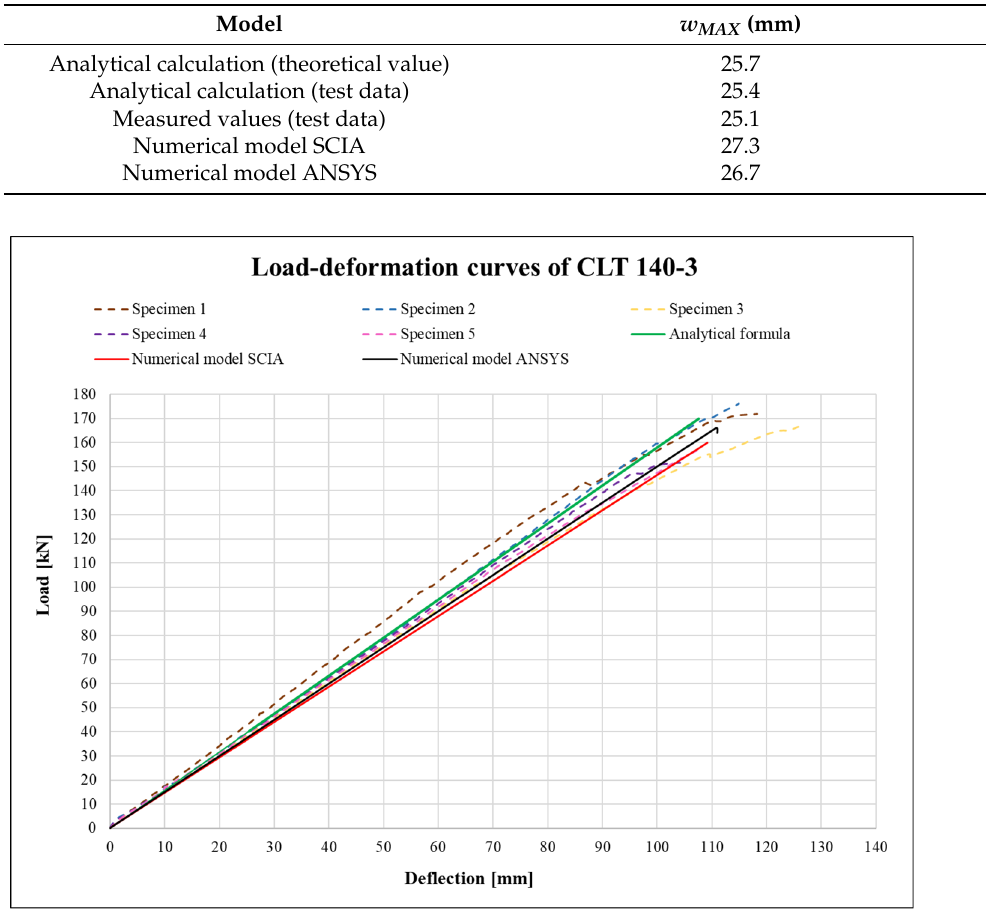
Table 8. Comparison of the maximum deflections.